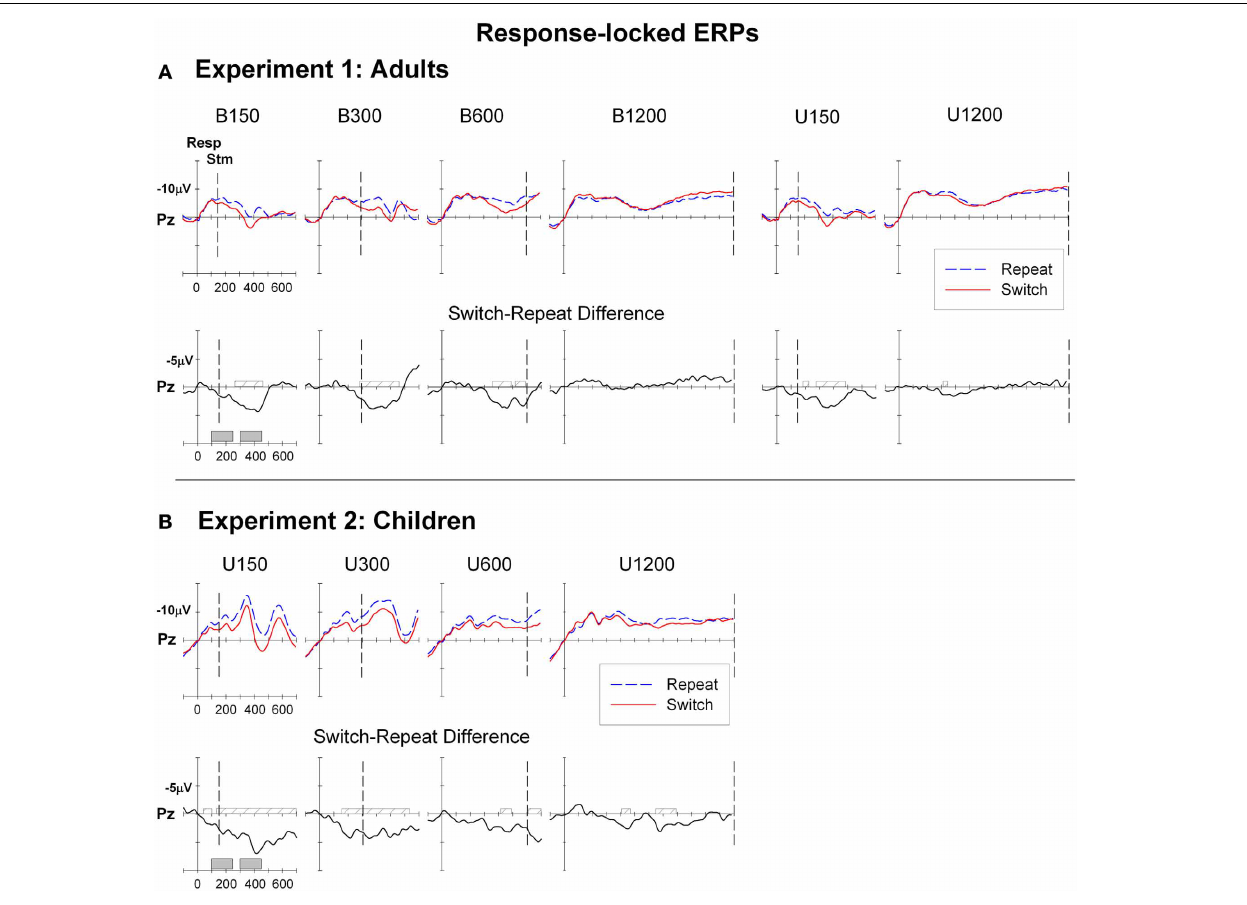
FIGURE 3 | Response-locked ERPs for switch and repeat trials and (switch—repeat) difference waveforms at Pz for (A): Experiment 1 (Adults) and (B): Experiment 2 (Children). Filled gray bars on timeline